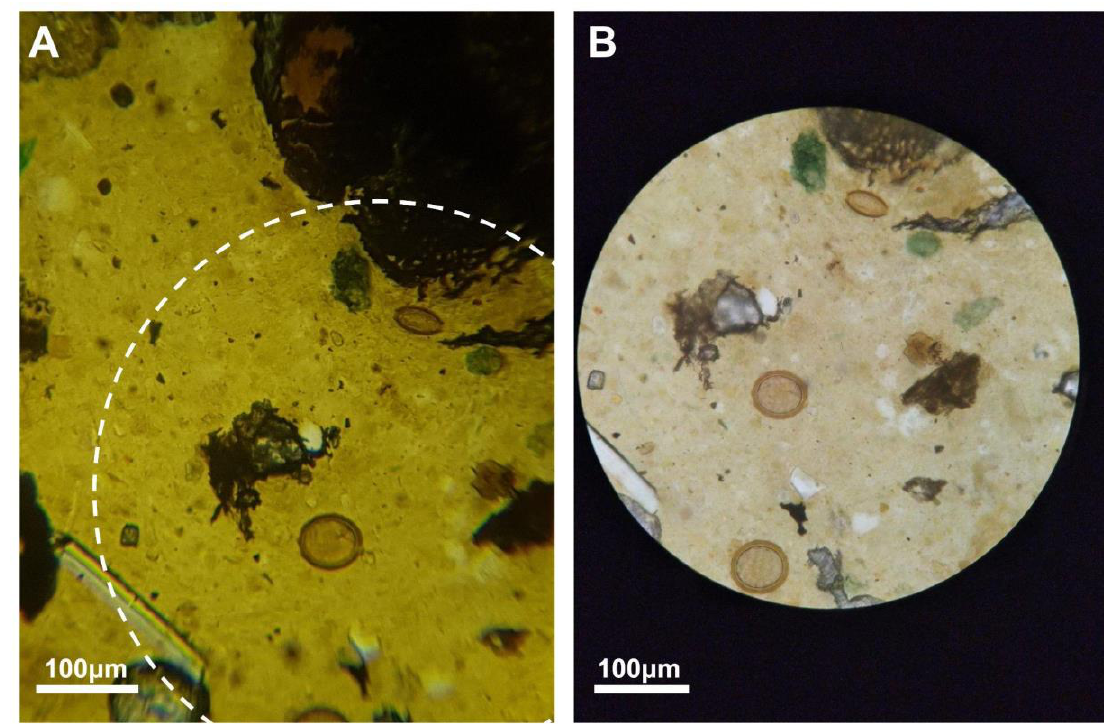
Figure 5. Comparison of images obtained from the same sample (Kato-Katz preparation) using ( A ) our proposed robotic microscope and ( B ) a conventional microscope (Leica DM-2000, 40× objective, field number 22). Both images were digitized using a Samsung S9. Note that the dashed line in panel A represents the digitized field of view presented in panel B.